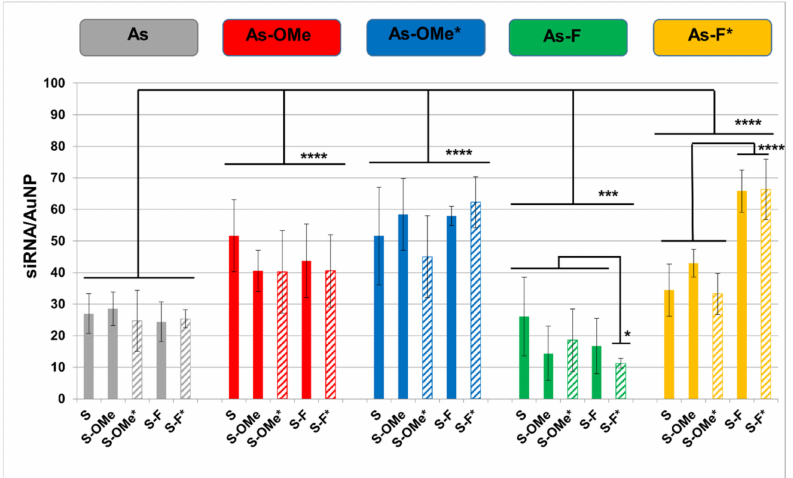
Figure 2. The influence of the chemical modifications on siRNA adsorption on AuNPs. siRNAs are categorized according to the type of their antisense strand; for clarity of presentation of the different categories, different colors are used. The boxes in the top row show categories according to the structure of the antisense strand (As) in siRNA. Colored vertical columns represent the data for each member of a category (each siRNA). Striped columns denote PG-modified siRNAs, and an asterisk (*) in an siRNA name means the PG-modified strand. The black lines combine sets of data that were compared with each other. Mean values ( ± SD) from at least four independent experiments are presented. The data were statistically assessed by one-way ANOVA. Significant differences between siRNA categories as well as siRNAs inside a category: * p < 0.05; *** p < 0.0005; **** p <